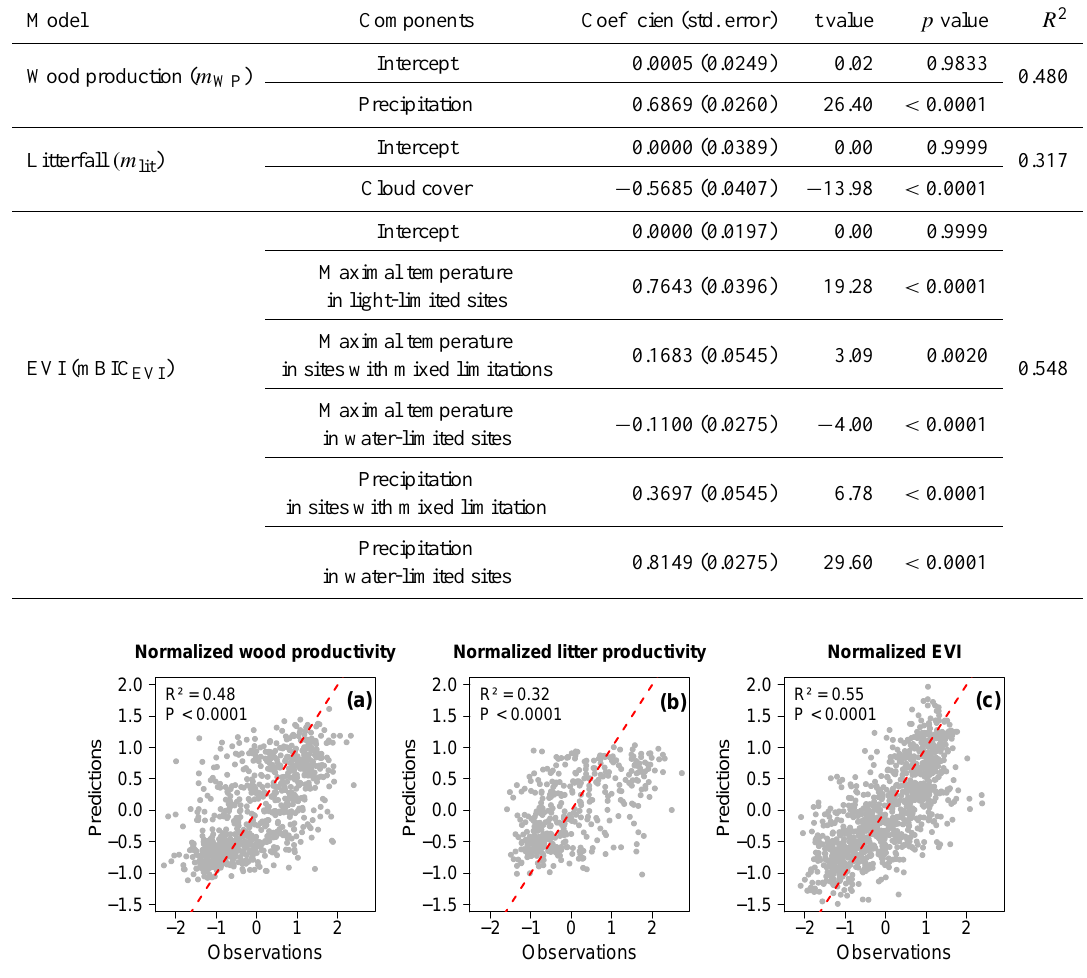
Figure 3. Observed vs. predicted monthly wood productivity under the model only with precipitation, m WP (a) ; litterfall productivity under the model only with cloud cover, m lit (b) ; and EVI the model only with precipitation, maximal temperature and site limitations, mBIC EVI (c) . The red dashed line is the identity line y = x . Parameters of the models are given in Table